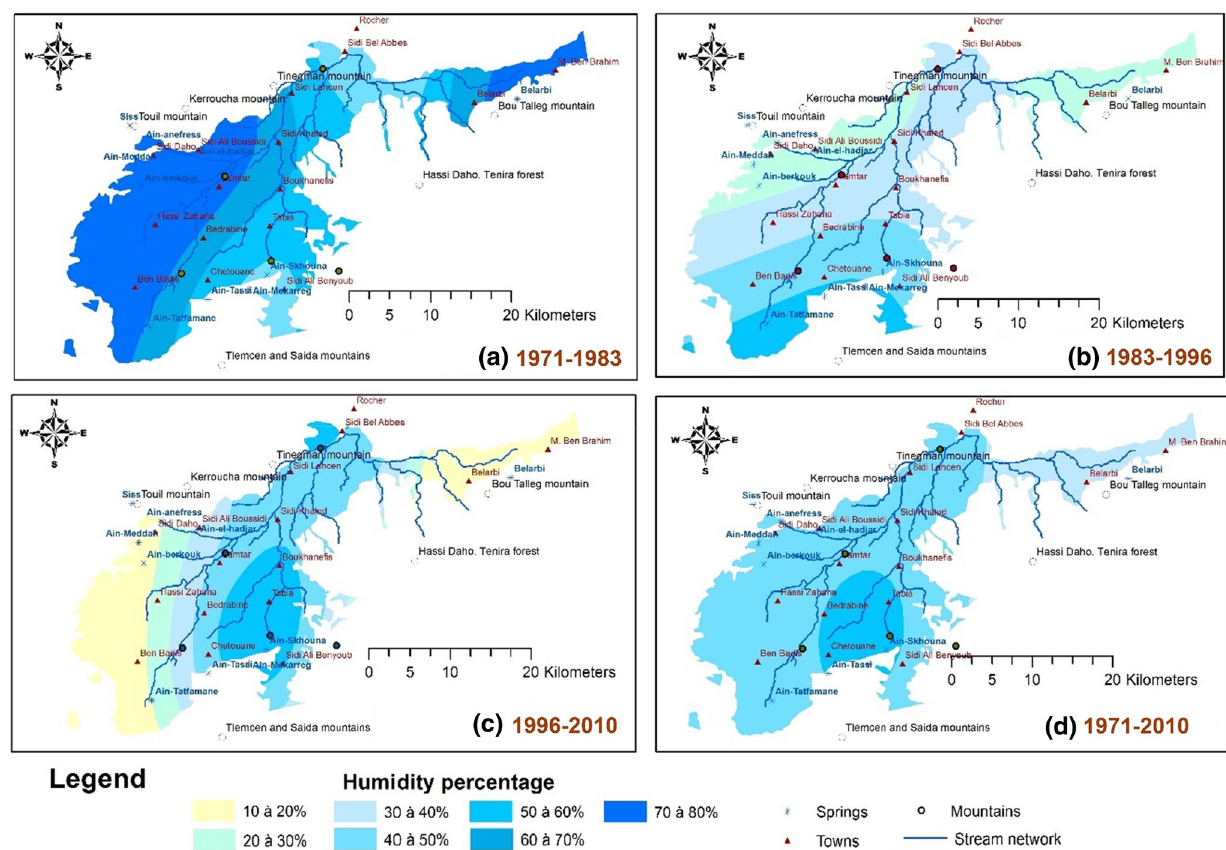
Fig. 8 Spatiotemporal distribution of humidity values over the entire observation series